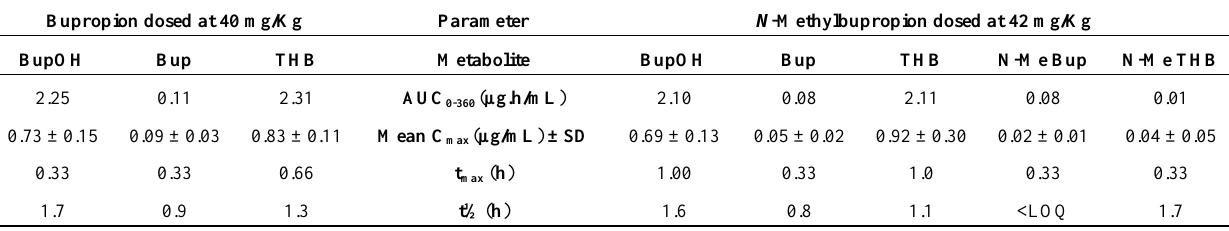
Table 4. Estimated pharmacokinetic parameters for N-methylbupropion, bupropion and metabolites following equimolar dosing via oral gavage. Dosed equimolar to bupropion 40 mg/Kg ( n = 5).